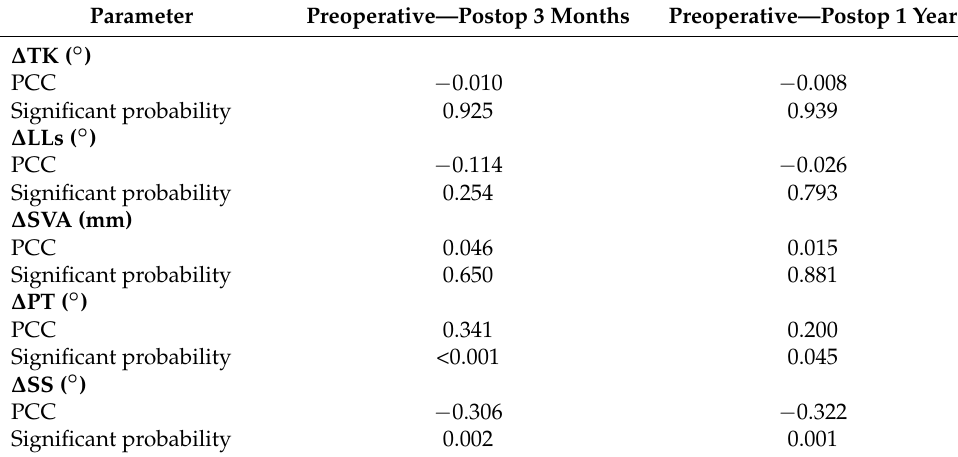
Table 4. Correlation analysis between sagittal ∆ HKA Rt-Lt angle and other parameters.